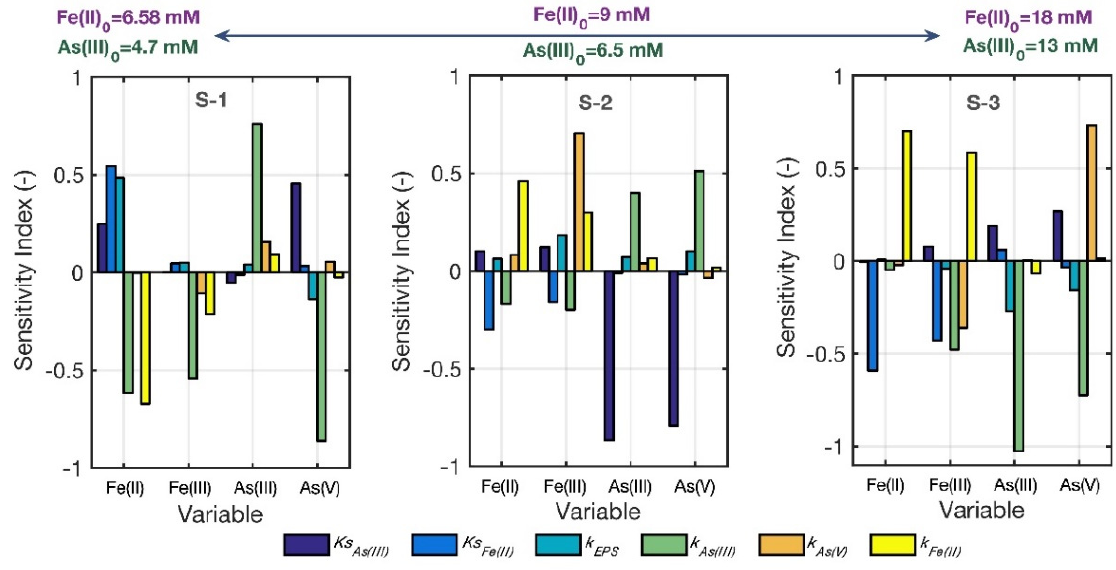
Figure 2. Sensitivity indices for the Fe(II), Fe(III), As(III) and As(V) variables from the experiments S-1, S-2 and S-3.